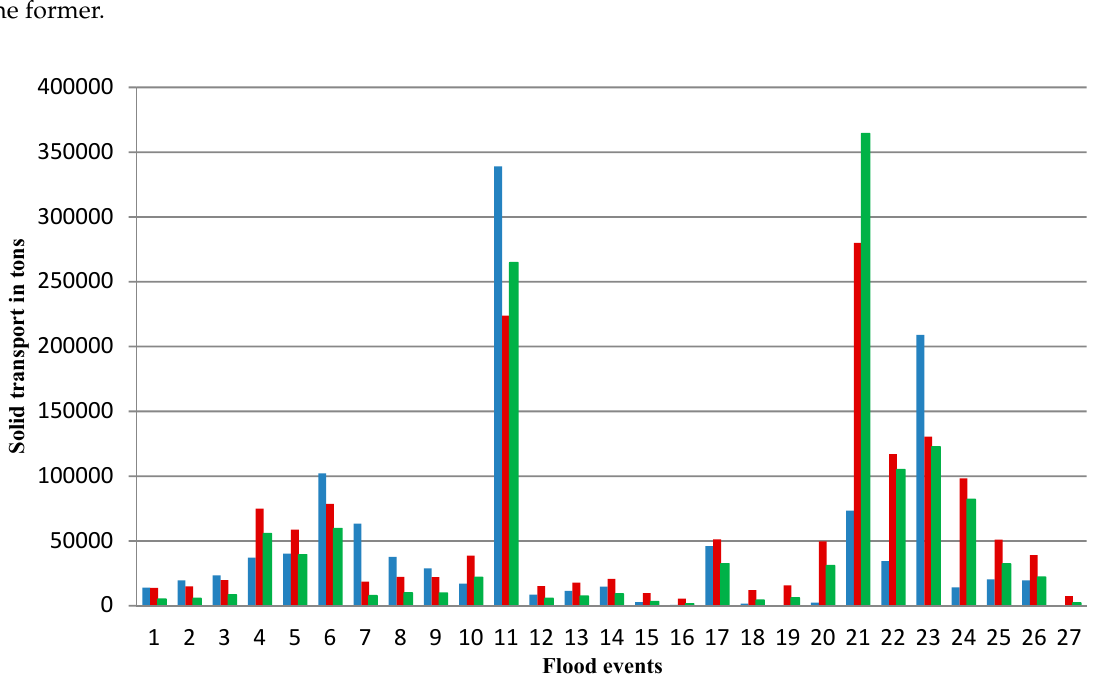
Solid transport (MUSLE_Calibrated) Figure 9. Comparison between MUSLE and observations at Aguibat Zear on the